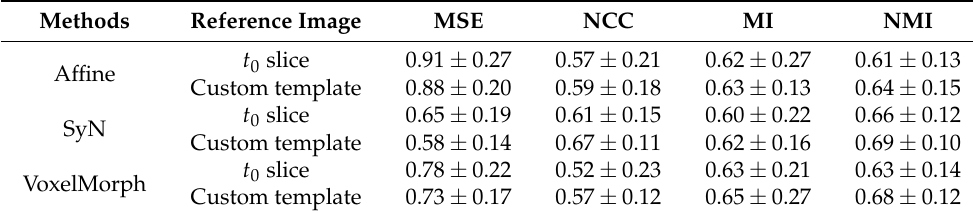
Table 5. The comparison of registration results of registration algorithms.